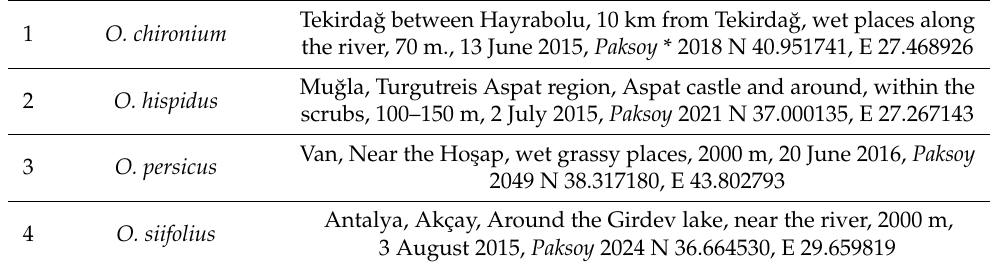
Table 2. Collection date and locality information for the studied Opopanax species. Tekirda˘g between Hayrabolu, 10 km from Tekirda˘g, wet places O. chironium